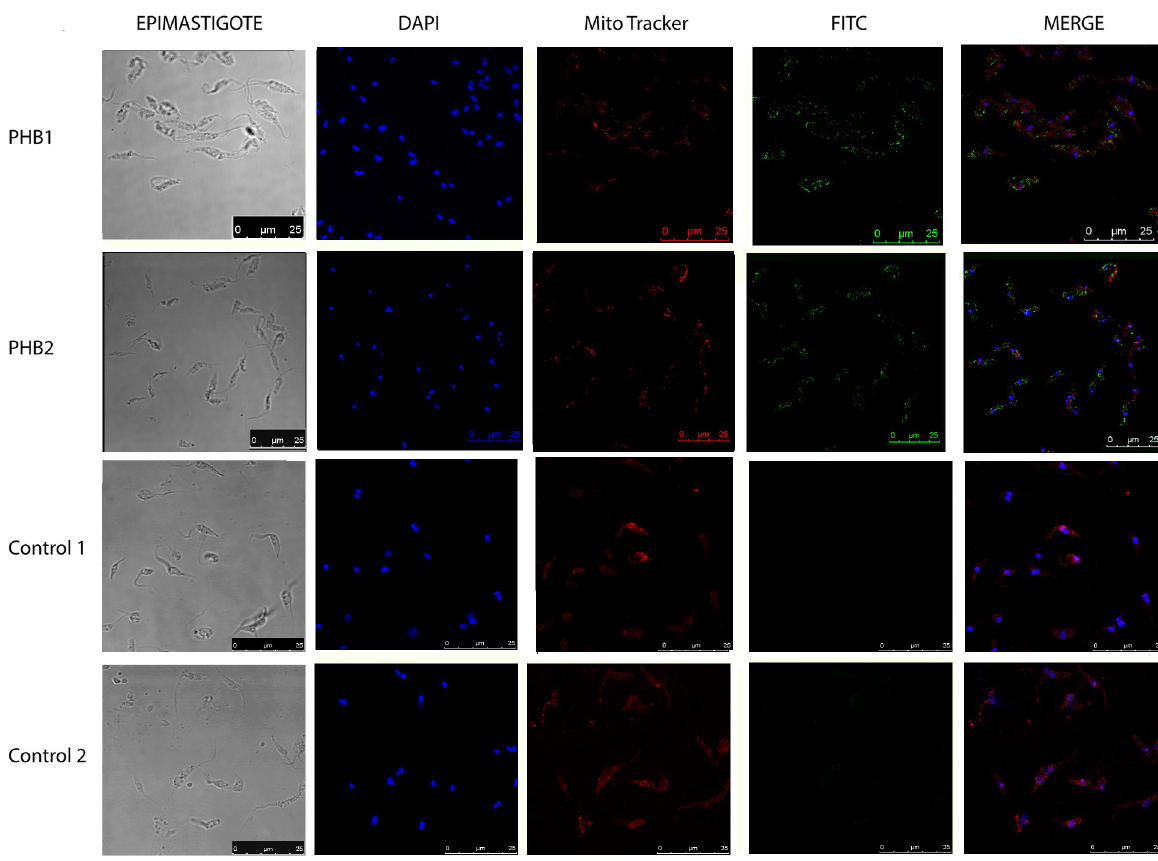
Fig 2. Fluorescence microscopy analysis in epimastigote forms of PHB1 and PHB2 using antibodies produced against T . cruzi PHB recombinant proteins. In blue, DAPI-labeled DNA; in red, the mitochondria labeled with MitoTracker; in green, PHB1 and PHB2 detected with FITC-conjugated secondary antibody. The merged images show the overlap of the green, red and blue channels.